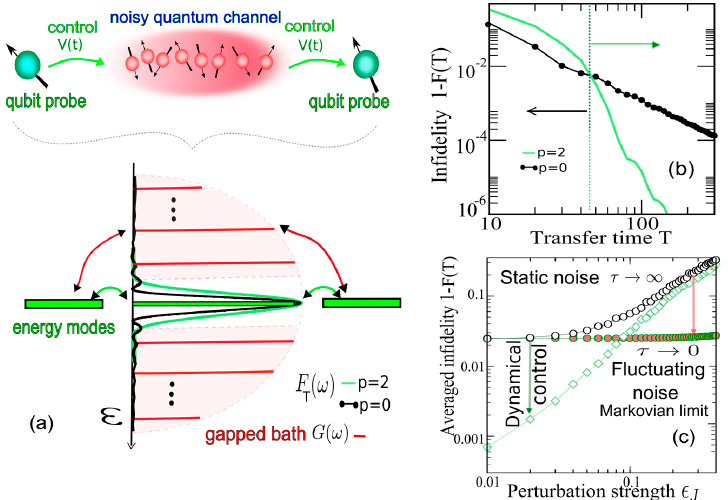
Figure 3. ( a ) Top: Controlled qubit probes coupled though a symmetric noisy quantum channel. In frequency space, the probes are resonantly coupled by a fermionic-mode of the channel whose energy is defined to be the energy origin (zero). These 3 degrees of freedom constitute the effective system (green rectangular bars); while the remaining channel modes are taken to be the bath (red lines) with a gapped spectrum G ± ( ω ) . Under noise, the perturbed energies change/fluctuate bounded by the (colored gapped) Wigner-semicircle. In the gap, the optimal spectral-filters for the high fidelity state-transfer F T , − ( ω ) correspond to dynamical boundary-control with V ( t ) : p = 0 (black dotted), p = 2 (green); ( b ) Transfer infidelity as a function of the transfer time T for the gapped Wigner-semicircle spectral bath: static control p = 0 (black dotted) and dynamic control p = 2 (green); ( c ) Averaged transfer infidelity 1 − F ( T ) as a function of the perturbation strength ξ V of the noisy channel. Dynamical p = 2 control (empty squares) strongly reduced the infidelity obtained under static control p = 0 (empty circles). A fluctuating noisy channel results in less damage than the static-noisy channel τ → ∞ , where its fidelity can even approach its unperturbed value in the Markovian limit τ → 0 ( p = 0, green solid circles) . Here N = 29 channel-qubits and V i ≡ To evaluate the transfer of any state of the source to the target qubit probes, we resort to a second-order solution of our non-Markovian master equation for the system density matrix [43] to obtain the state-transfer fidelity averaged over all possible input states. Similarly to Section 5, complete state transfer through the mediated mode, in the absence of a bath, occurs when the accumulated phase over time (cid:1846) , Equation (37), due to the modulation control (cid:1848)(cid:3560)((cid:1872)) , satisfies (cid:2038)((cid:1846)) = (cid:3095) 6.2. Optimized Filter Design for Channel Diagnostics Modulation can control the transfer infidelity through the convoluted overlap of the bath and filter spectra governed by